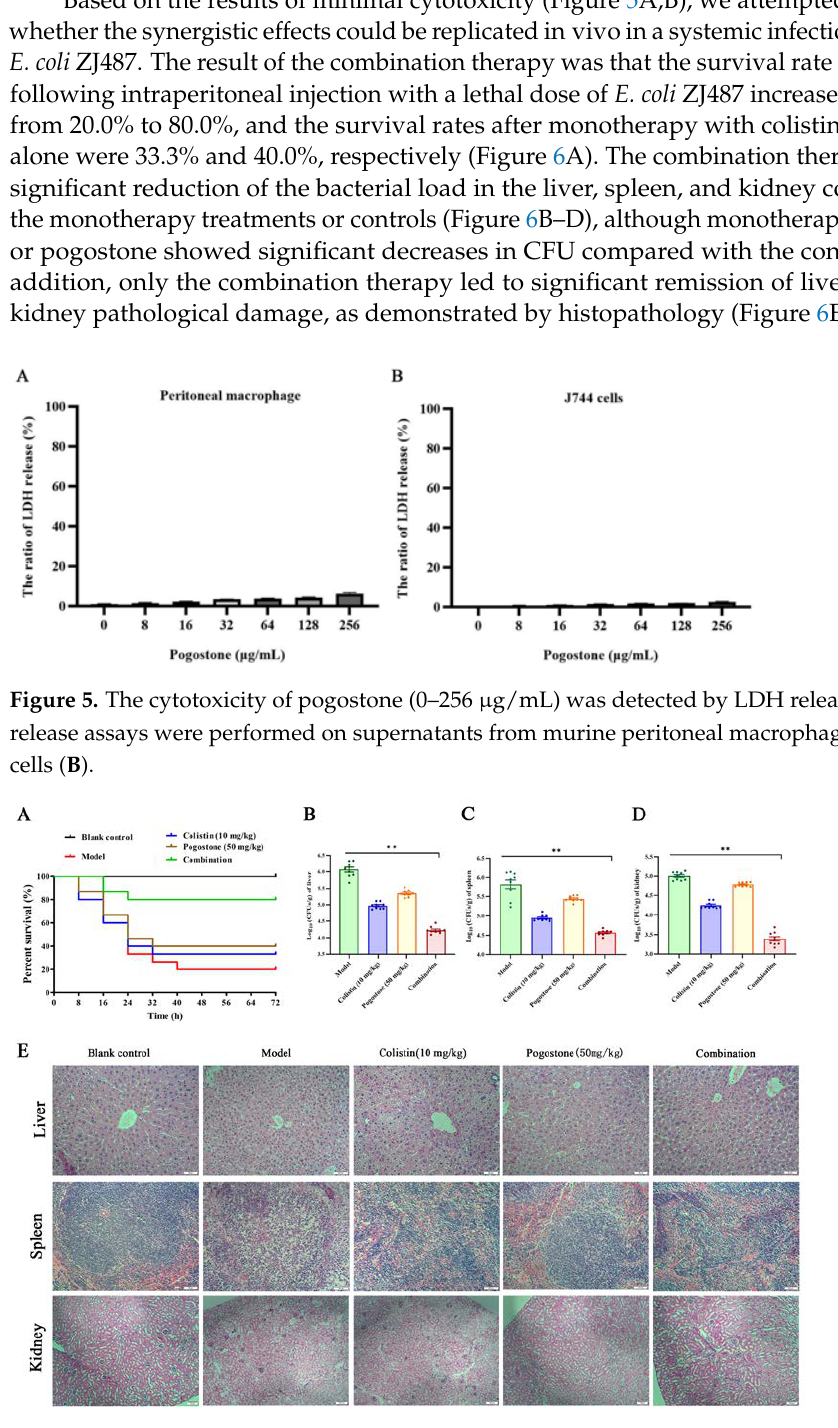
Figure 6 . Effects of the combination therapy with colistin and pogostone in vivo. The mice were infected by intraperitoneal injection with E. coli ZJ478. The survival rate ( A ) and the bacterial loading of the liver, spleen, and kidney were calculated ( B – D ). The histopathological changes of liver, spleen, and kidney of the mice in different groups are shown in ( E ). ** p < 0.01. 3. Discussion An increasing number of human deaths from antimicrobial-resistant bacterial infec- tions has attracted significant attention in the global community [15,16]. Thus, these infec- tions have become a research priority of institutions for disease control and prevention. The pathogenic bacteria include methicillin-resistant Staphylococcus aureus (MRSA) and several multidrug-resistant (MDR) Enterobacteriaceae such as NDM-positive Enterobacteri- aceae and MCR-positive Enterobacteriaceae [2]. Antibiotics can protect humans and animals from bacterial infections. Antimicrobial resistance limits treatment options, and this has led to increased infection-related morbidity and mortality. Of note, bacteria often possess one or more mechanisms of resistance to specific antibiotics. Polymyxins, one of the first